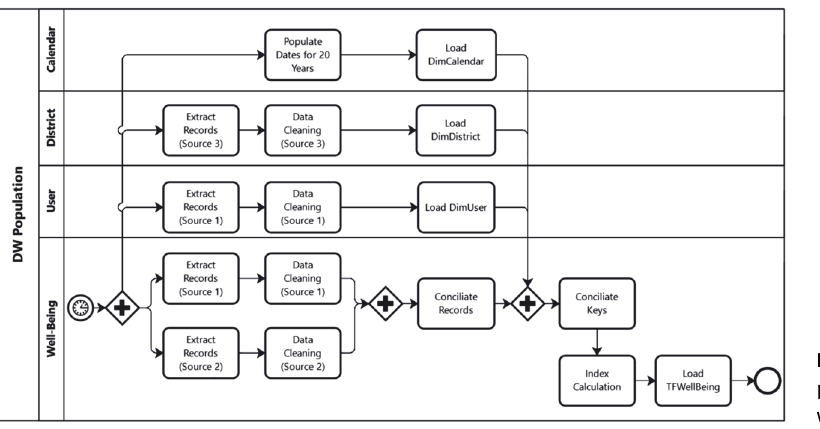
Figure 3: Methodology used to populate the tables of the data warehouse (BPMN schema).